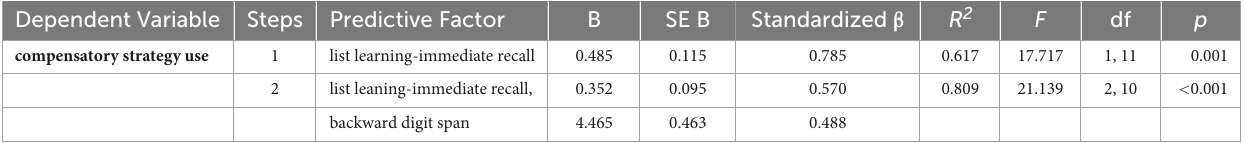
TABLE 5 Summary of the second set of stepwise regression analyses regarding the neuropsychological tests with the greatest contribution to compensatory strategy use, as assessed by the IADL-C